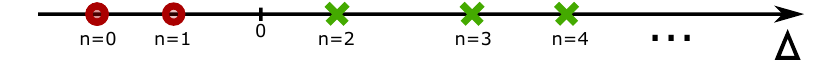
(cid:0)p (cid:0) E , which relates the spec-